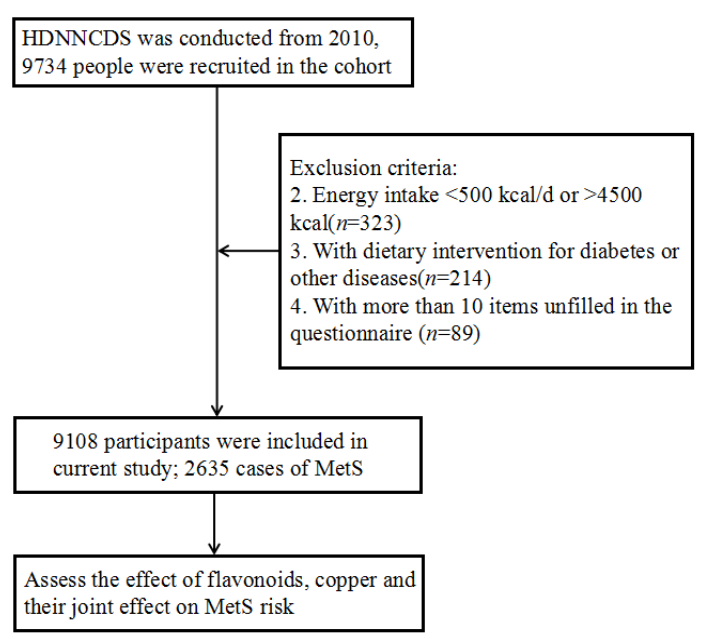
Figure 1. The flow diagram of this study. HDNNCDS is the Harbin Cohort Study on Diet, Nutrition, and Chronic Non-Communicable Diseases and MetS is metabolic syndrome.